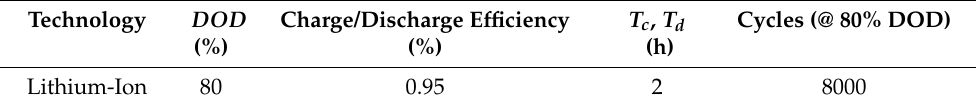
Table 2. Main characteristics of the storage system considered in the study